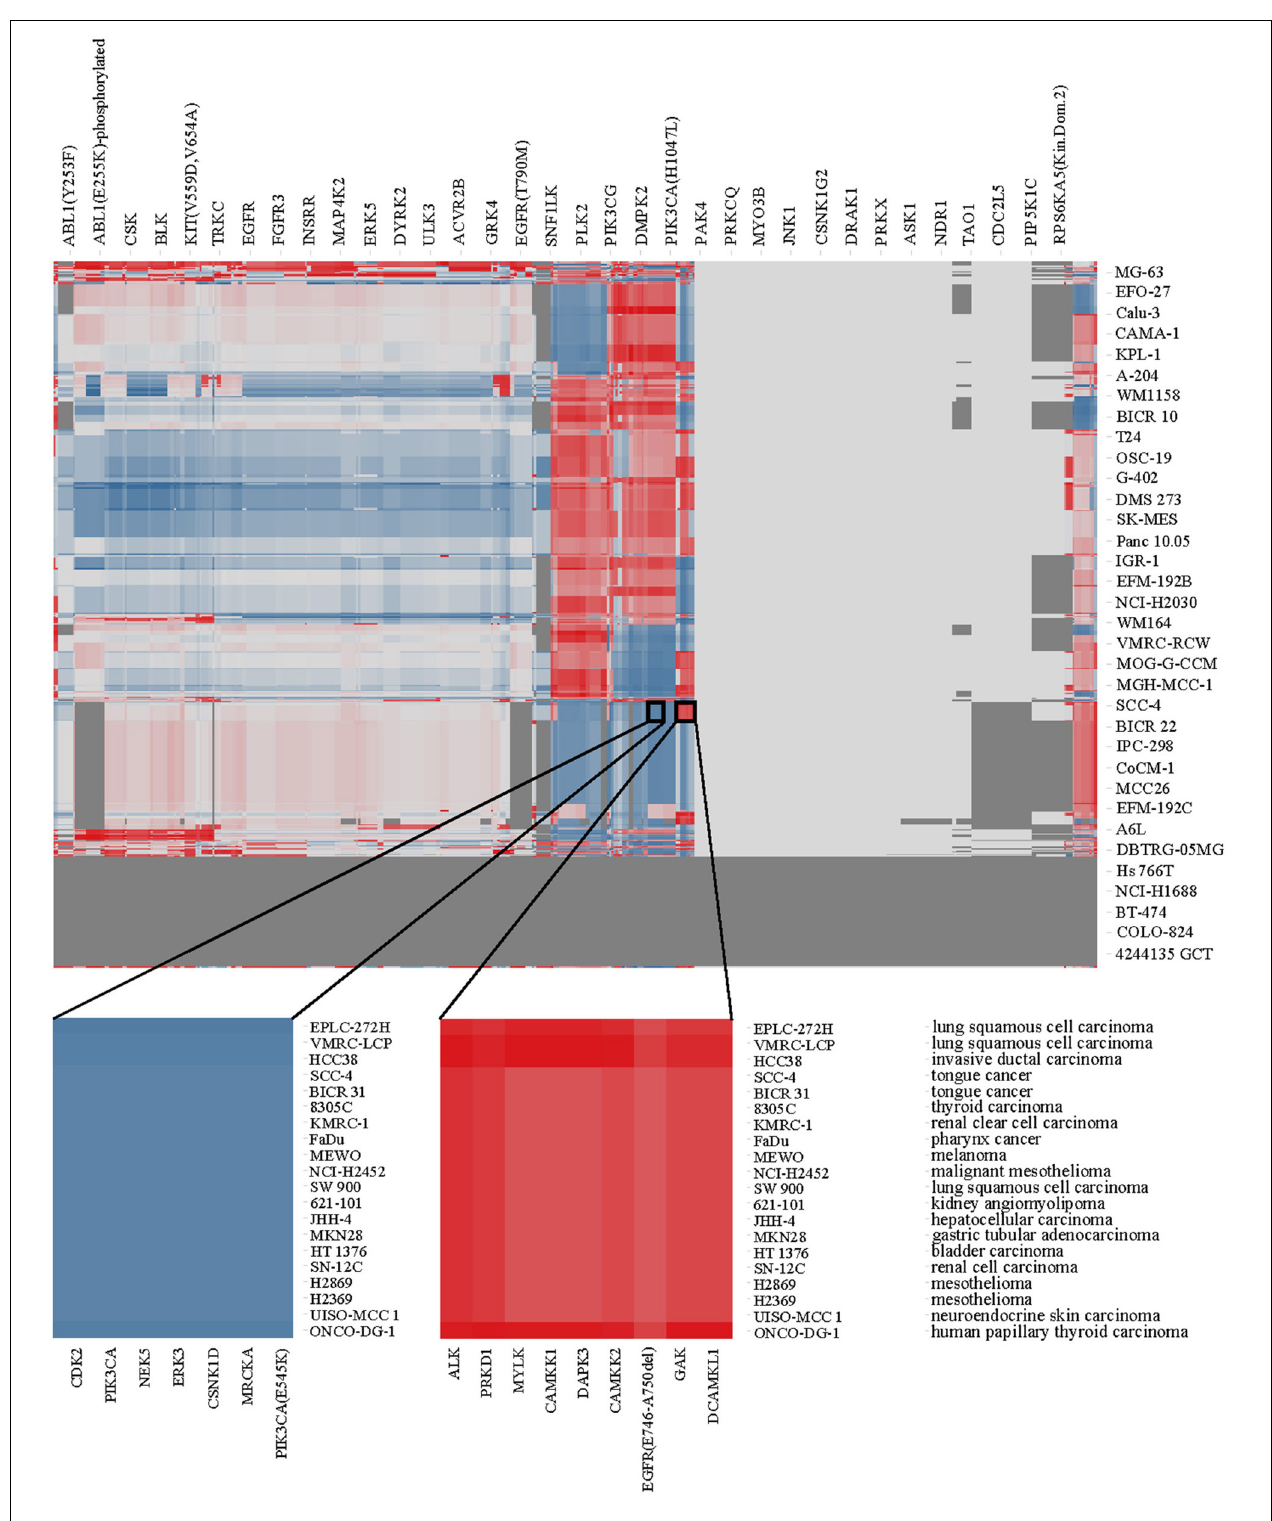
FIGURE 4 | Heat map of kinase enrichment across cell lines as described in the text. Two circles focused on the area of high enrichment (red) and derichment (blue), respectively (the gradient color mode range shown from